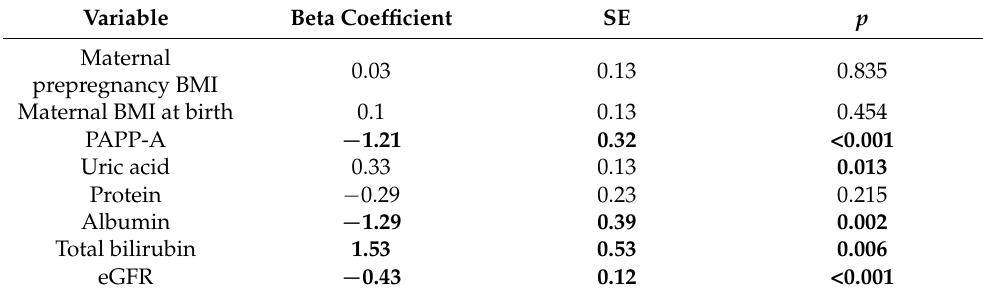
Table 2. Univariable linear regression models for the clinical and laboratory variable selection. Variable